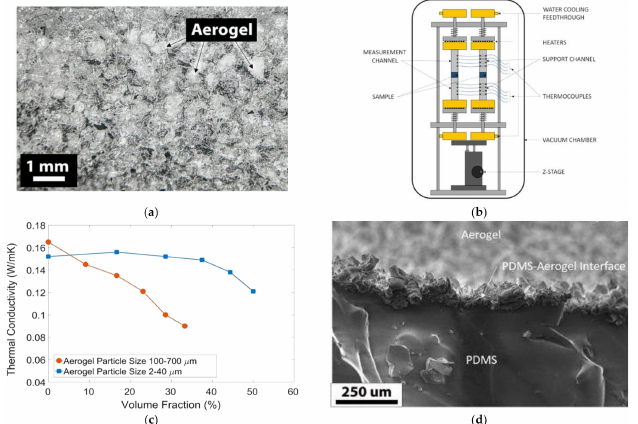
Figure 7. PDMS-aerogel composite cross-section ( a ); the measurement system of sample’s thermal conductivity ( b ); composite’s thermal conductivity ( c ); the aerogel-silicone interface’s cross-section ( d )